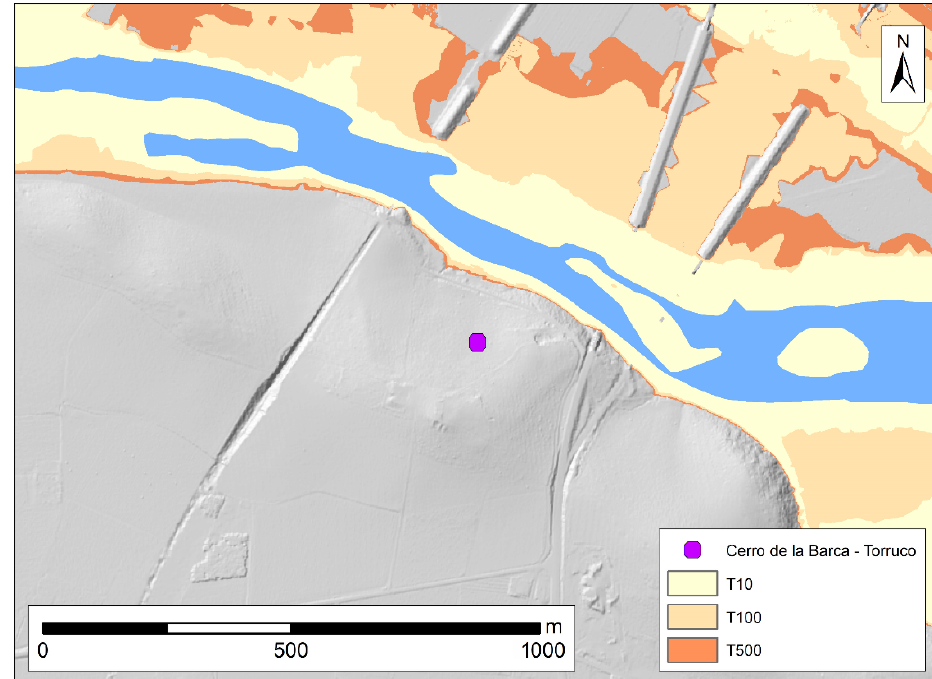
Figure 15. APSFR analysis corresponding to the territory in which the settlement of Cerro de la Barca—Torruco (Villanueva de la Serena, Badajoz, Spain) is located. It shows that none of the recorded events affect the site.